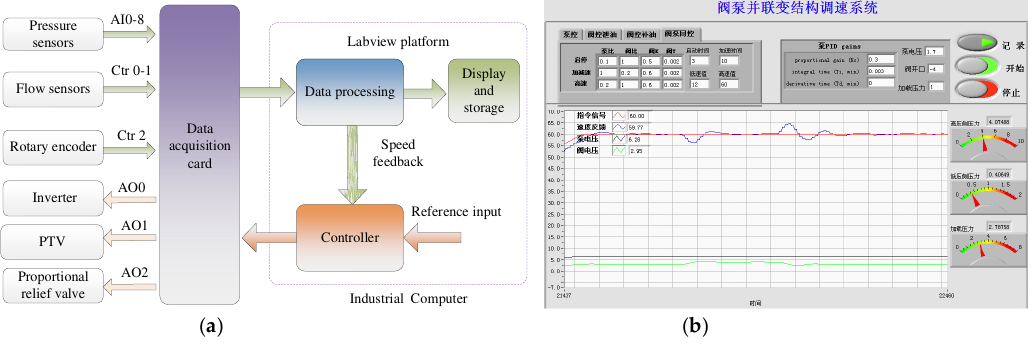
Figure 5. Measurement and control system. ( a ) Control principle; ( b ) Interface.